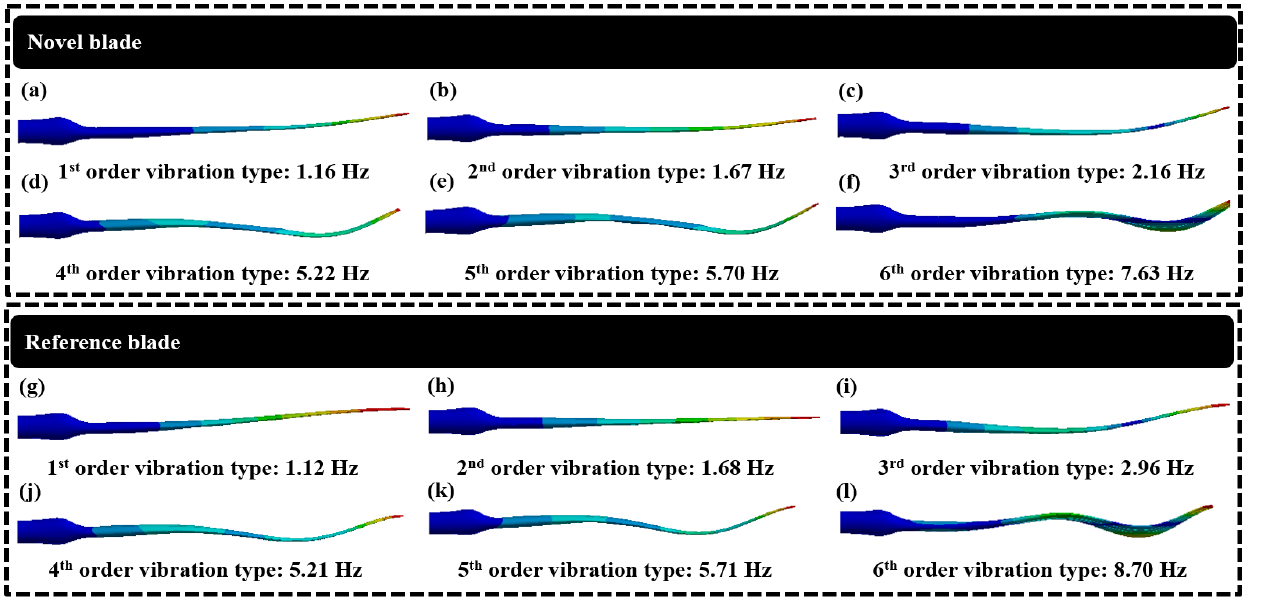
Figure 8. Vibration types of the novel and reference turbine blades. Table 9. Comparison of frequency between the novel and reference turbine blades. Frequency (Hz) Order Ref. Blade Nov. Blade